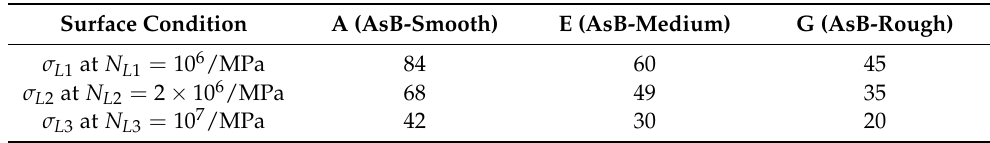
Table 8. Estimated stress for different endurance limit values N L . Surface